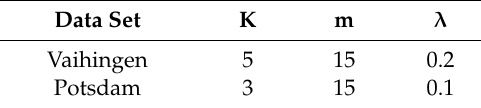
Table 1. Experimental parameter settings.